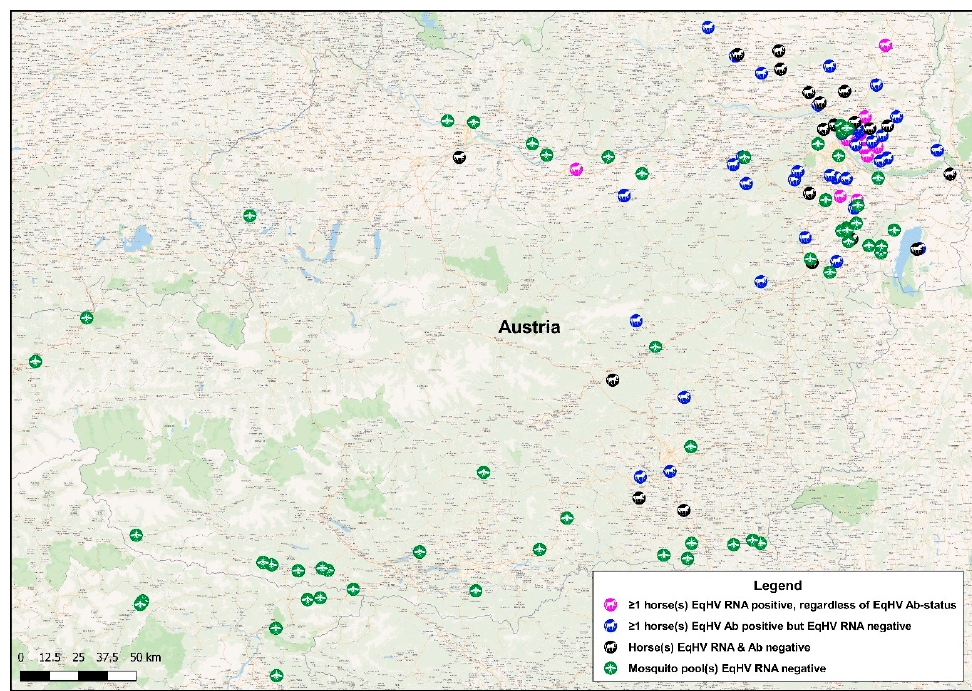
Figure 1. Geographical locations of sampling sites. A map of Austria indicating mosquito collection sites and the properties of origin of sampled horses. Green mosquito-icons each represents the collection site of a minimum of one mosquito pool. Magenta horse-icons each represents a property where at least one horse tested equine hepacivirus (EqHV) RNA-positive, regardless of the EqHV antibody-status of the horses on these properties. Blue horse-icons each represents a property where all horses tested EqHV RNA-negative, but at least one horse tested EqHV antibody-positive. Black horse-icons each represents a property where all horses tested EqHV RNA-negative, as well as EqHV antibody-negative. Table 1. Information pertaining to the 12 properties where EqHV RNA ‐ positive horses were identified, including the EqHV infection ‐ state of the sampled populations.